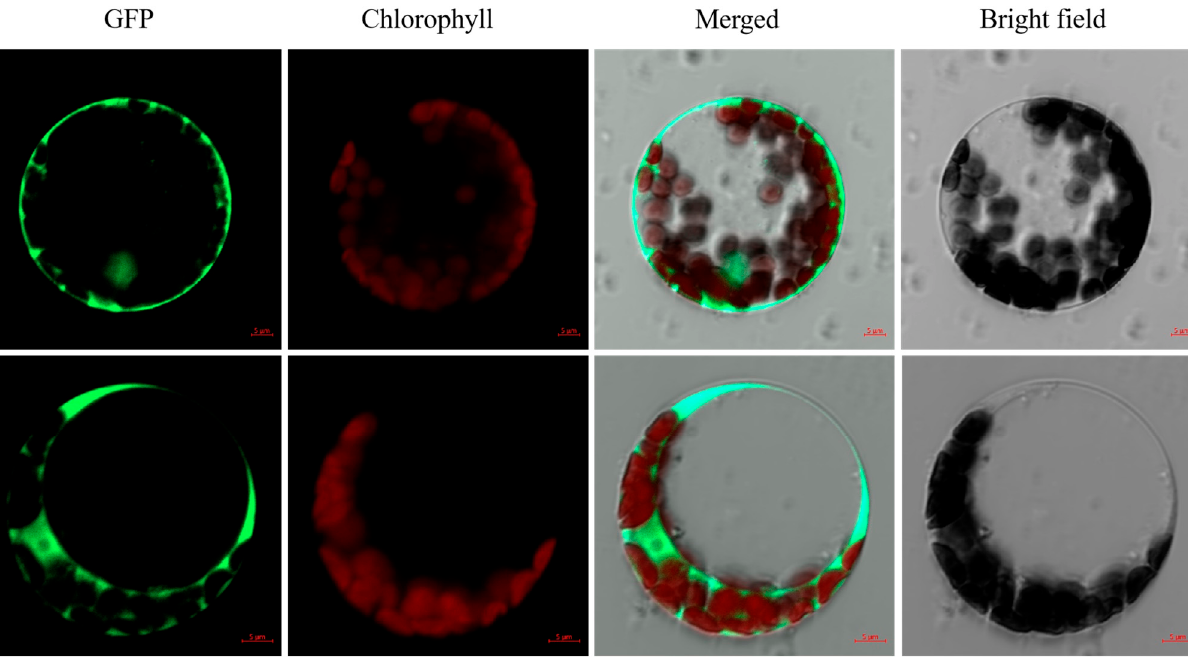
Figure 10. Subcellular localization of BoGAPC-GFP fusion protein. GFP control is the empty control, and Bo-GAPC is experimental. The scale is 5 µm.